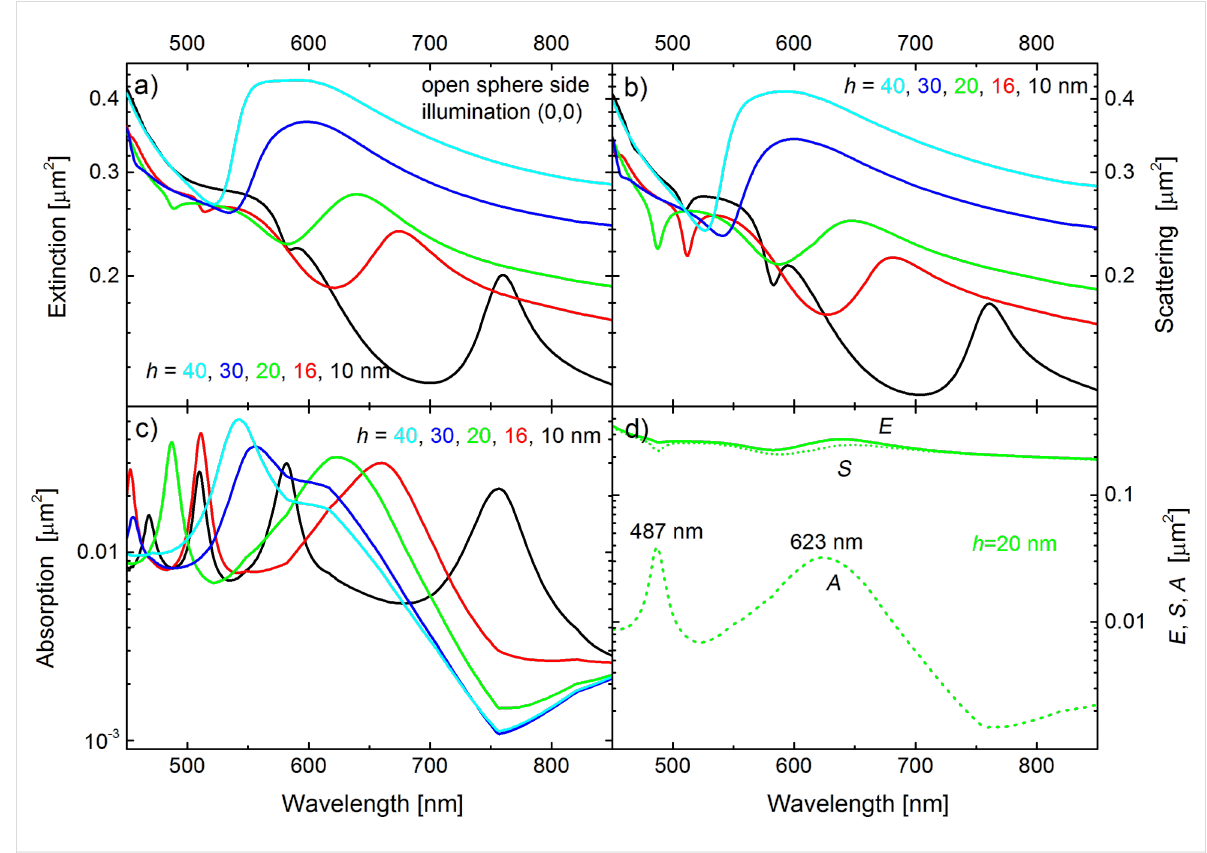
Figure 2: Cross sections of the (a) extinction, (b) scattering and (c) absorption of a PS sphere of diameter d = 390 nm, without fluorophores, and capped with a Ag semi-shell of variable thickness h , as given by the color coding. The incident plane wave was oriented in (0,0) direction, i.e., impinging from the open sphere side. The plasmonic resonances are most prominent in the absorption spectra. (d) compares the extinction ( E ), scat- tering ( S ) and absorption ( A ) spectra for the specific shell thickness h = 20